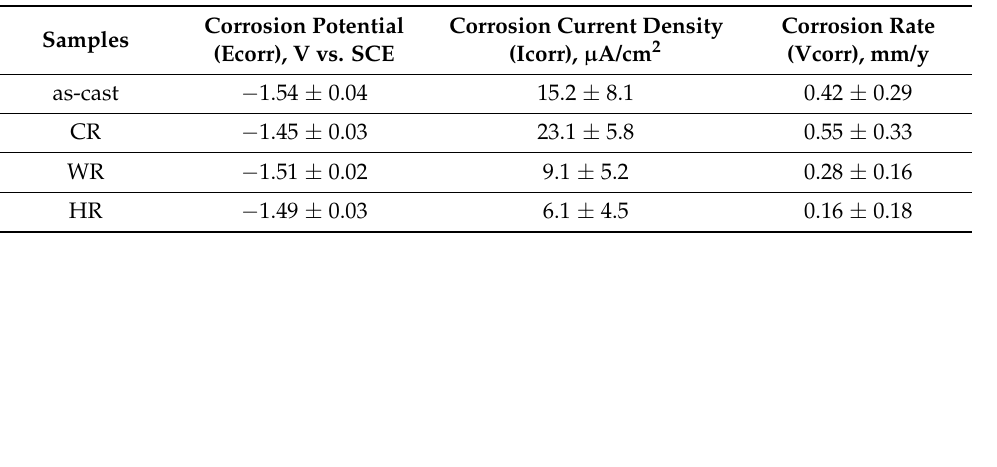
Figure 7. Electrochemical performance of WE43 magnesium alloy in Hanks’ solution. ( a ) Open circuit potential, ( b ) potentiodynamic polarization curves, ( c ) bode plots, and ( d ) Nyquist plots and equivalent circuits. Table 3. Electrochemical performance parameters of the Mg alloys in Hank’s solution.